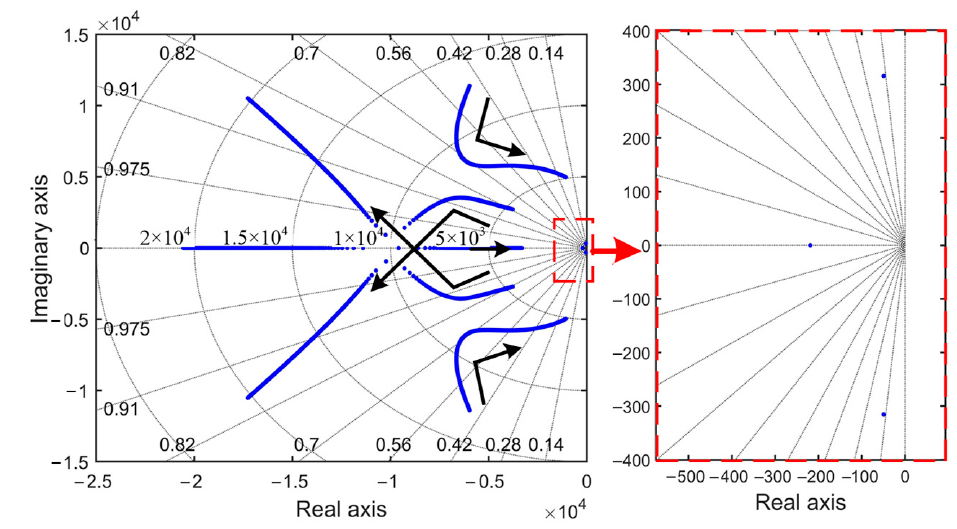
Figure 9. Roots locus diagram of the characteristic polynomial with parametric variations.